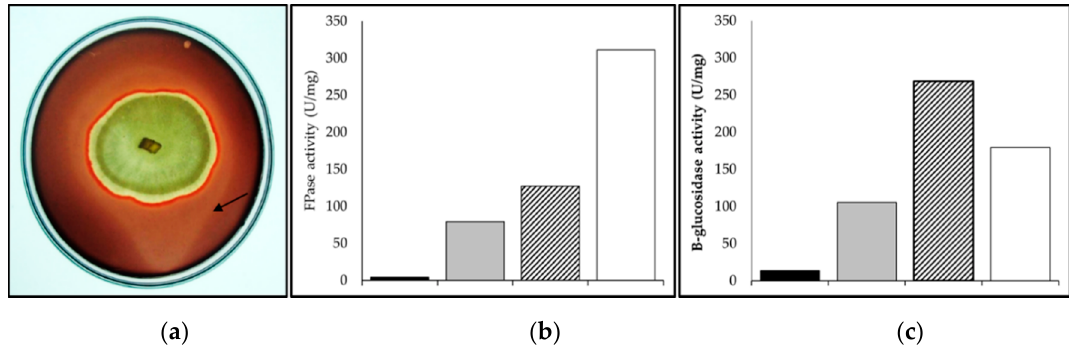
Figure 4. Cellulolytic activities of culture supernatants from the Trichoderma sp. grown on di ff erent food manufacturing wastes (FMWs). ( a ) The Trichoderma sp. was grown on a Petri plate containing carboxymethyl cellulose and stained with Congo red solution. The white halo is indicative of the presence of cellulases released into the culture medium. The arrow indicates the lack of staining due to the activity of cellulases secreted by the fungus ( b ) Filter paper activity (FPase) from culture supernatants ( c ) β -glucosidase activity from culture supernatants. For b and c, the culture supernatants were extracted on the fifth day of growth in Mandel medium supplemented with glucose (black bar), OMSW (gray bar), TP (striped bar), and GP (white bar). Activities are expressed in mg of total protein. For FPAase, the activity, expressed in U / mL, was 2.6, 63.2, 33.0, and 112.0, respectively. For β -glucosidase, it was 0.2, 1.7, 1.6, and 1.4 U / mL,